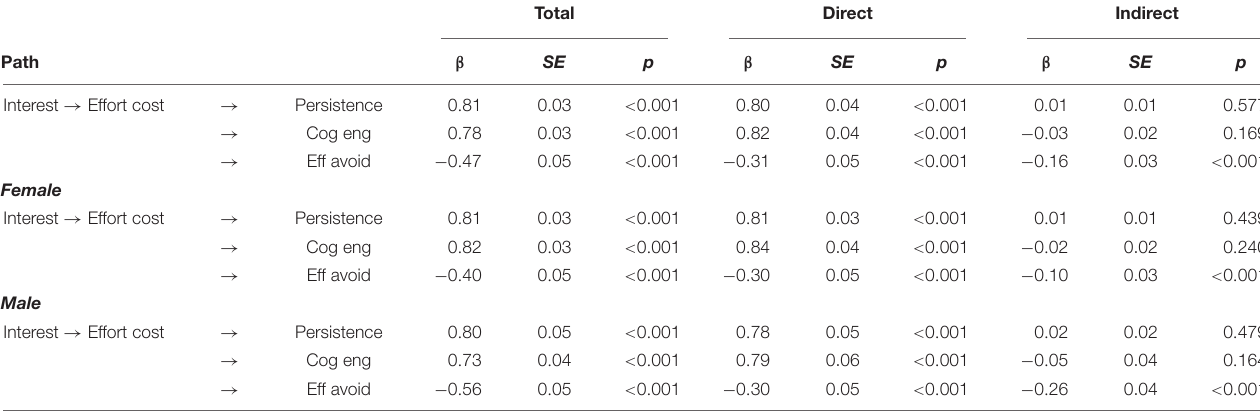
TABLE 4 | Total, direct, and indirect effects of indirect paths.